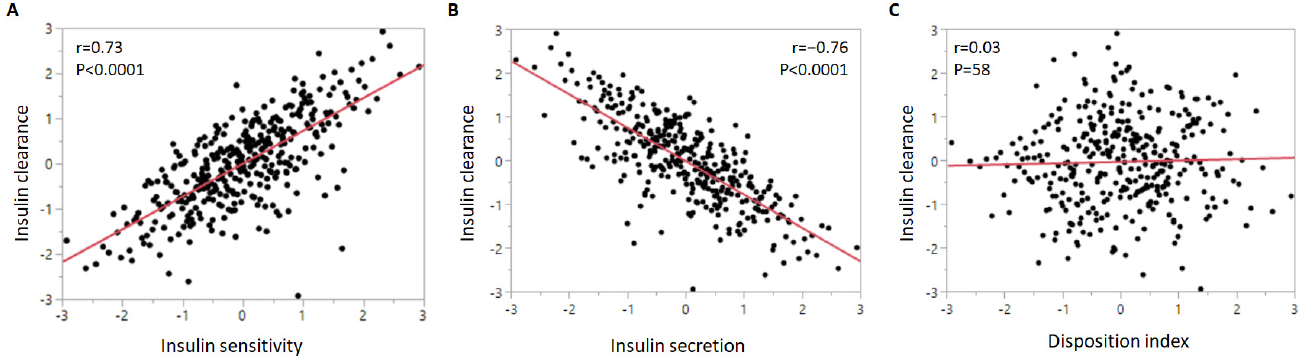
Figure 1. Correlation of insulin clearance with ( A ) insulin sensitivity, ( B ) insulin secretion, and ( C ) disposition index. The insulin homeostasis traits were inverse normal transformed. Table 1. Clinical and glucose and insulin homeostasis characteristics by glycemic